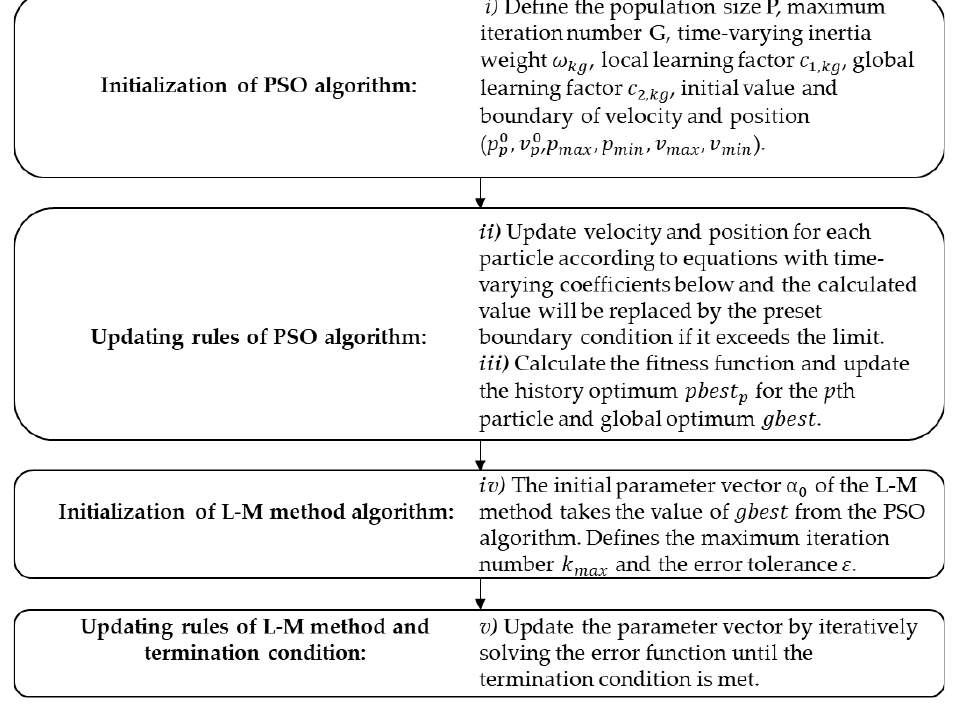
Figure 1. Major steps of the joint parameter identification algorithm.